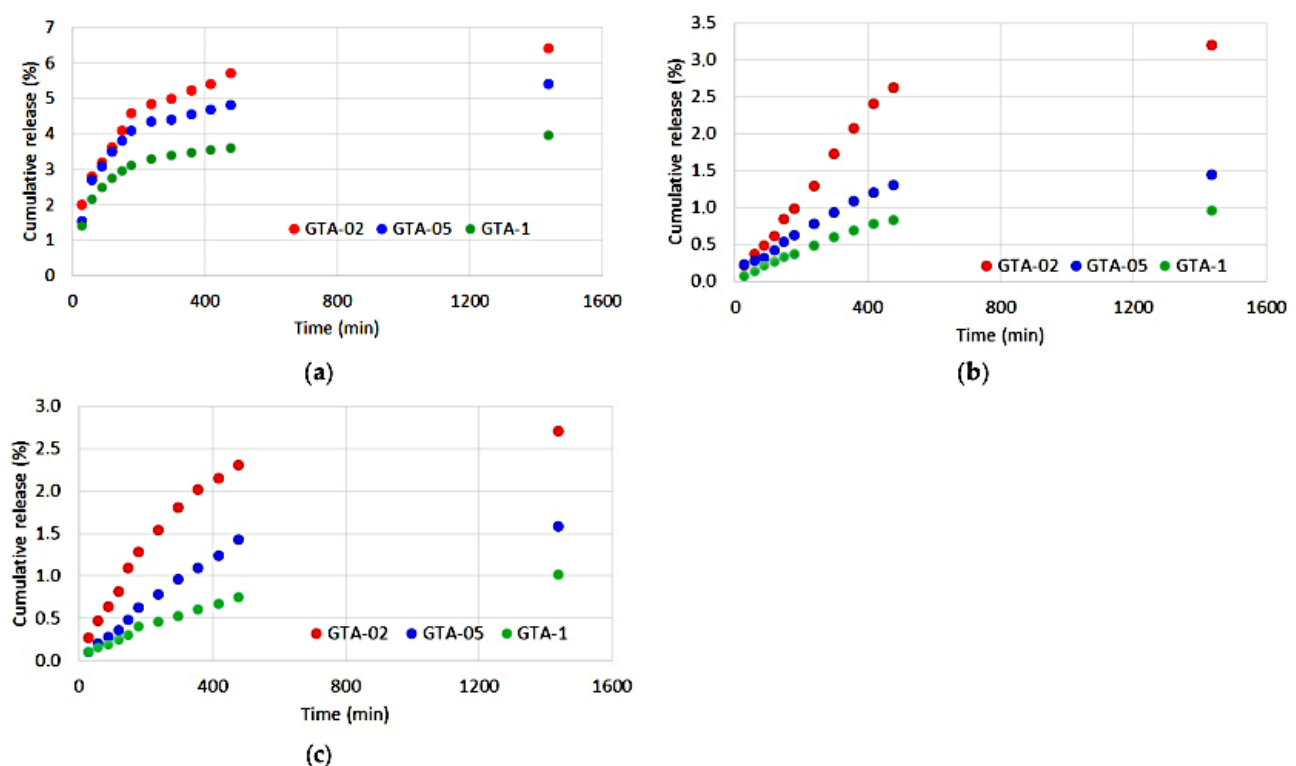
Figure 7. Curcumin cumulative release, expressed as a percentage of the initial content, from GTA films incubated in ( a ) H 2 O/EtOH solution (1:1); ( b ) physiological solution and ( c ) PBS.